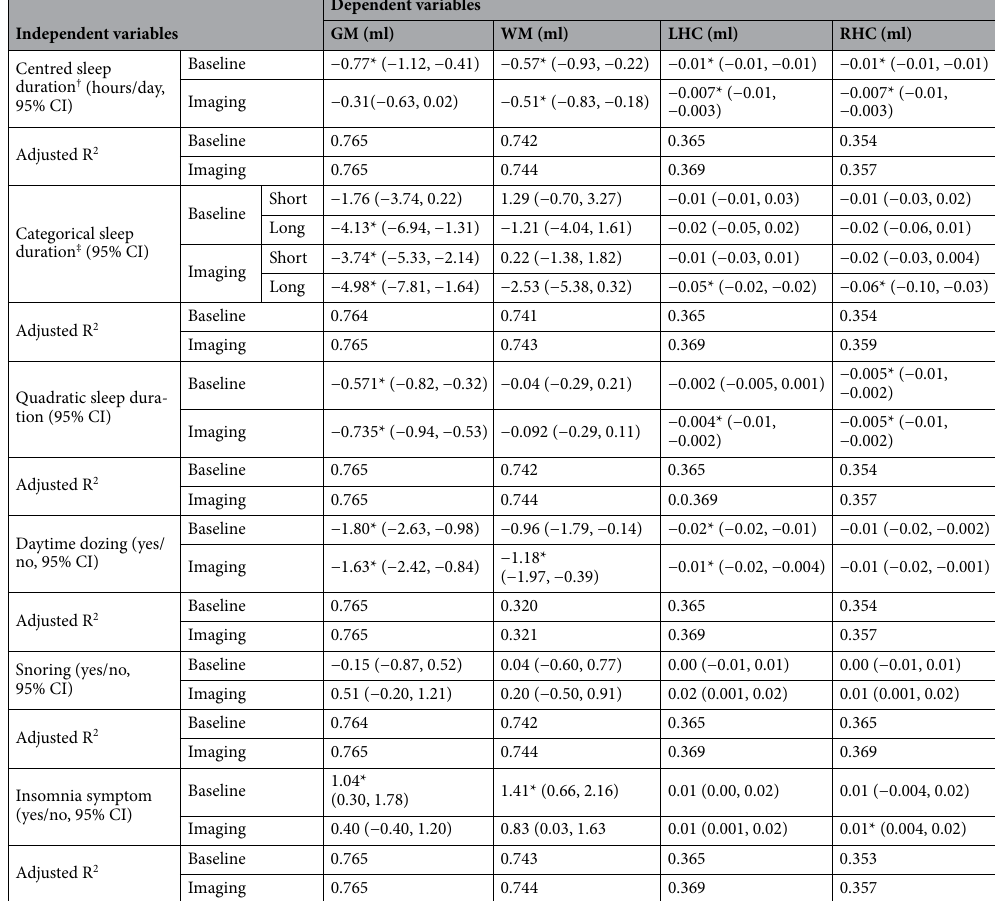
Table 1. Association between sleep characteristics and brain volumes (n = 29,545). The estimates are controlled for the following covariates: age, sex, education, body mass index, smoking, alcohol, physical activity, hypertension, and diabetes. 95% CI 95% confidence interval. *p-value < 0.0125; p-value is considered significant after Bonferroni correction. † Sleep duration is centred on 7 h of sleep per day. ‡ Normal sleep duration refers to 6–9 h of sleep per day; normal sleep duration is the reference group; short sleep duration refers to less than 6 h of sleep per day; long sleep duration refers to more than 9 h of sleep per